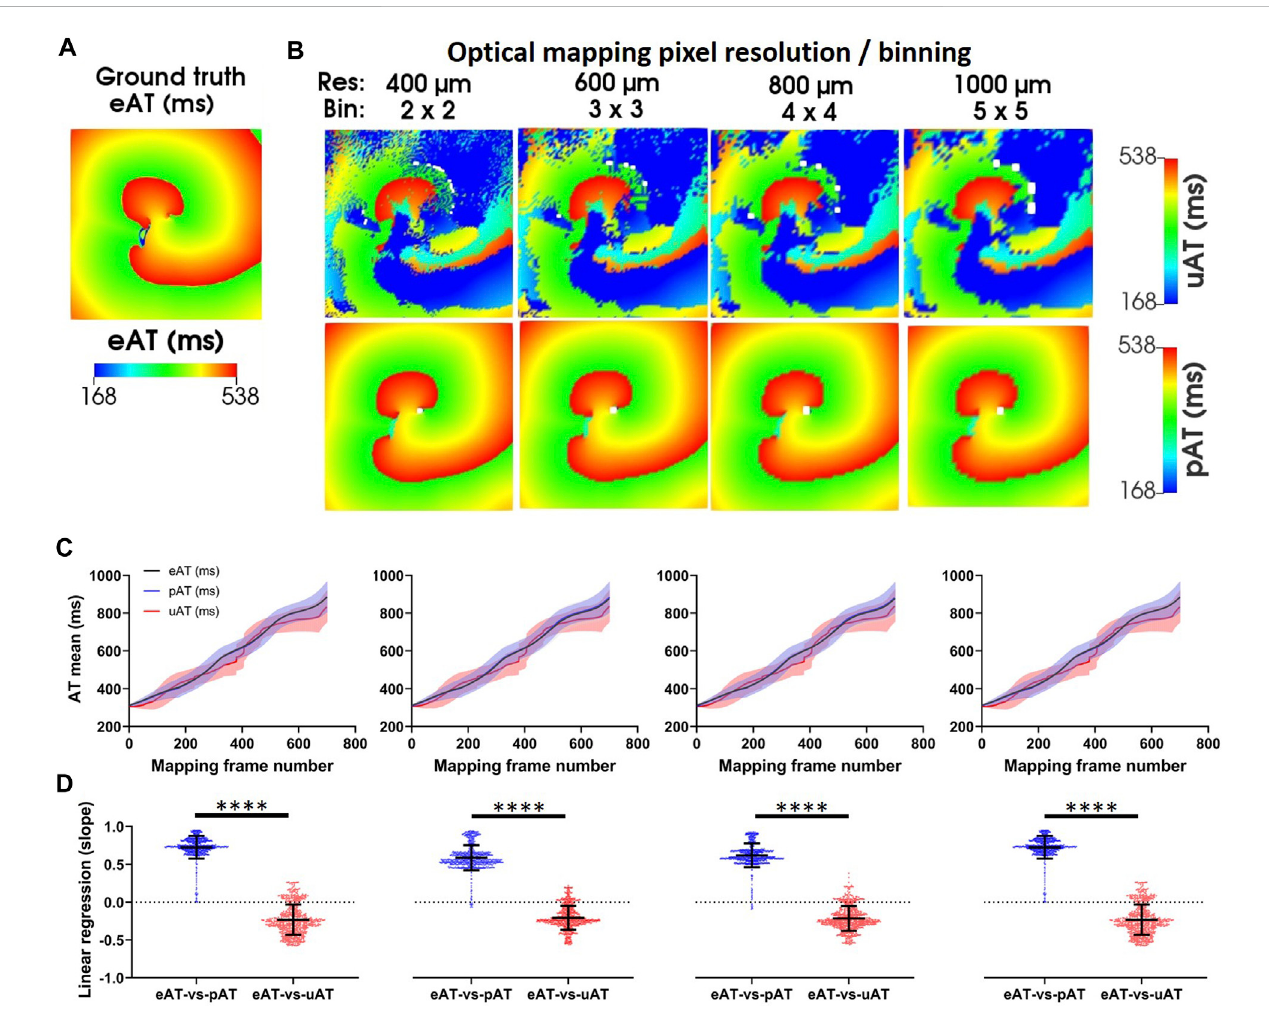
FIGURE 8 SimulationsofpATmappingandimageresolution. (A) GroundtrutheATderivedfromasimulationoftheunderlyingelectricalactionpotential. (B) Optical mapping signals were derived from electrical simulations in (A) . The effects of image resolution evaluated on uAT and pAT derived from optical mapping signals. Opticalmapping signals werederived from downsampledelectrical simulations to simulate reduction of imageresolution from 400 μ mto 1,000 µm. (C) Mean ± standard deviation eAT, uAT, and pAT from dynamicAT maps of the full simulation. (D) Linear regressionof pixel-to-pixel correlations ofeAT with uAT and